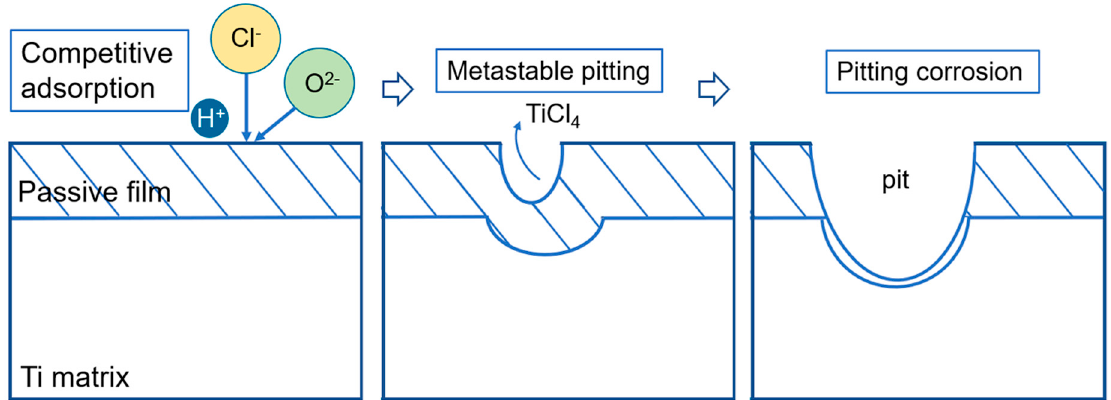
Figure 10. Mechanism of the passive film growth and dissolution according to the point defect model: reactions (1–5) are the physicochemical processes that occur on the passive film. 𝑇𝑖 (cid:3021)(cid:3036) is Ti ions in the cation site of the passive film, Vö is oxygen vacancies in the passive film, 𝑉 (cid:3021)(cid:3036)(cid:2872) (cid:4594) is Ti ion vacancies in the passive film, 𝑉 (cid:3021)(cid:3036) is vacancies in the Ti substrate, 𝑒 (cid:4593) is an electron, 𝑂 (cid:3042) is oxygen ion in the anion site of the passive film, 𝑇𝑖 ((cid:3028)(cid:3044))(cid:2872)(cid:2878) is Ti ions in solution.